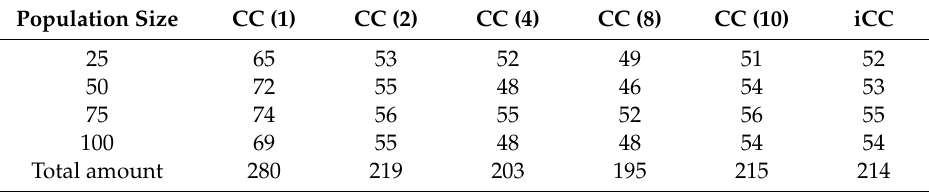
Table 7. The Holm test, ε -CC-SHADE (m) vs. ε -iCC-SHADE p-value = 0.05.